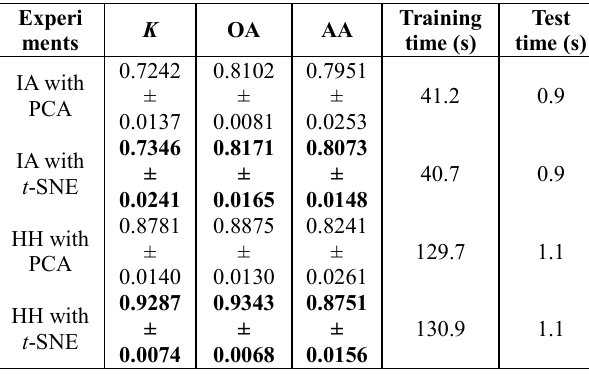
Table 2 . Classification accuracies and running time